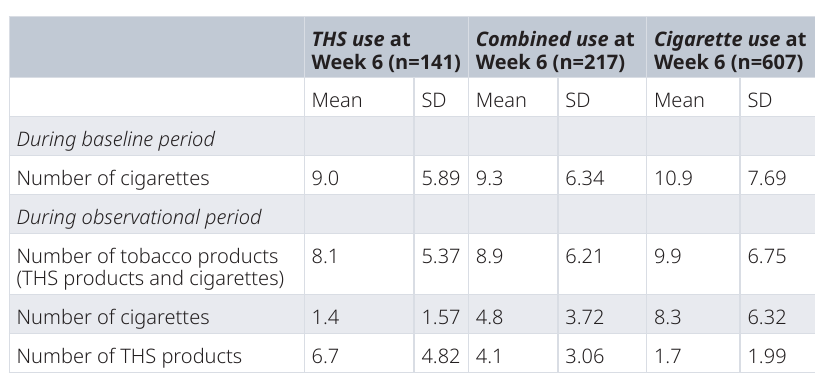
Table 2. Number of THS sticks and/or cigarettes reported per day in different main product use categories 1